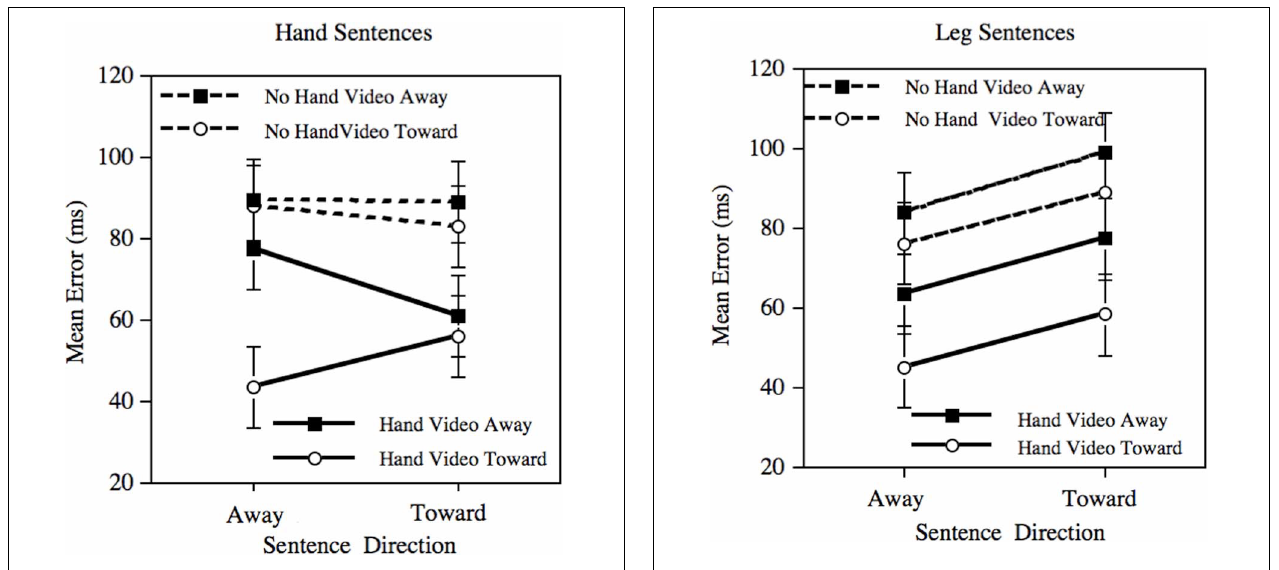
(Toward or Away), and whether a hand was visible or not in the video.